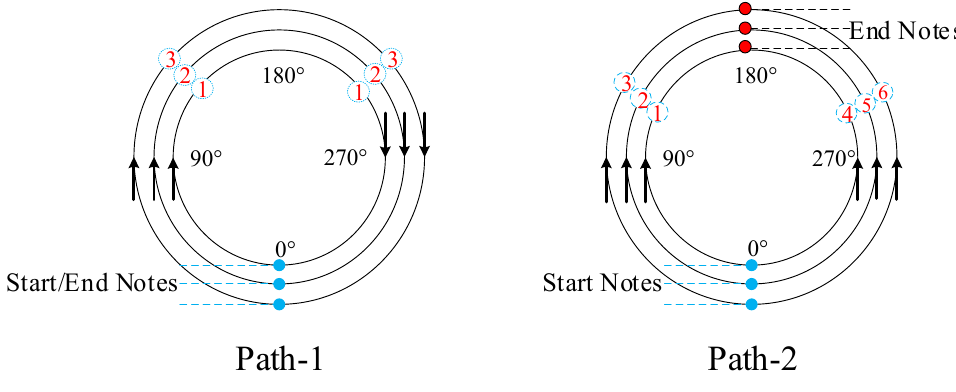
Figure 7. Two welding sequences.